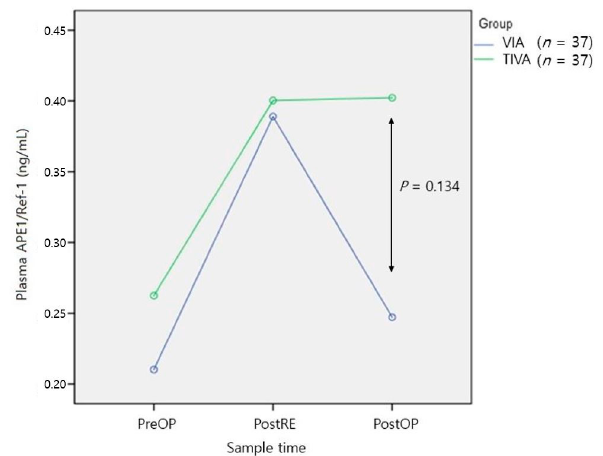
Figure 3. Comparison of plasma APE1/Ref-1 levels between two groups. VIA, volatile inhaled anesthesia; TIVA, total intravenous anesthesia; PreOP, preoperative sample; PostRE, postresection sample; PostOP, postoperative sample.